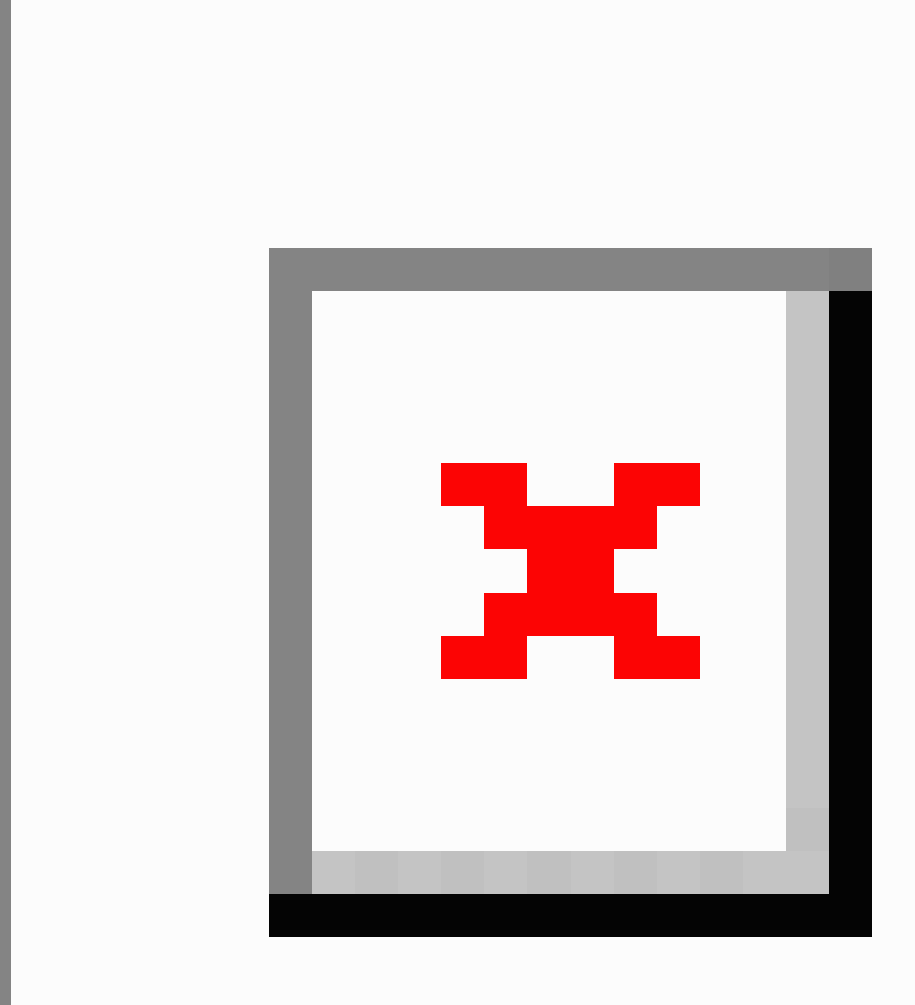
Figure 2. The MindWave mobile